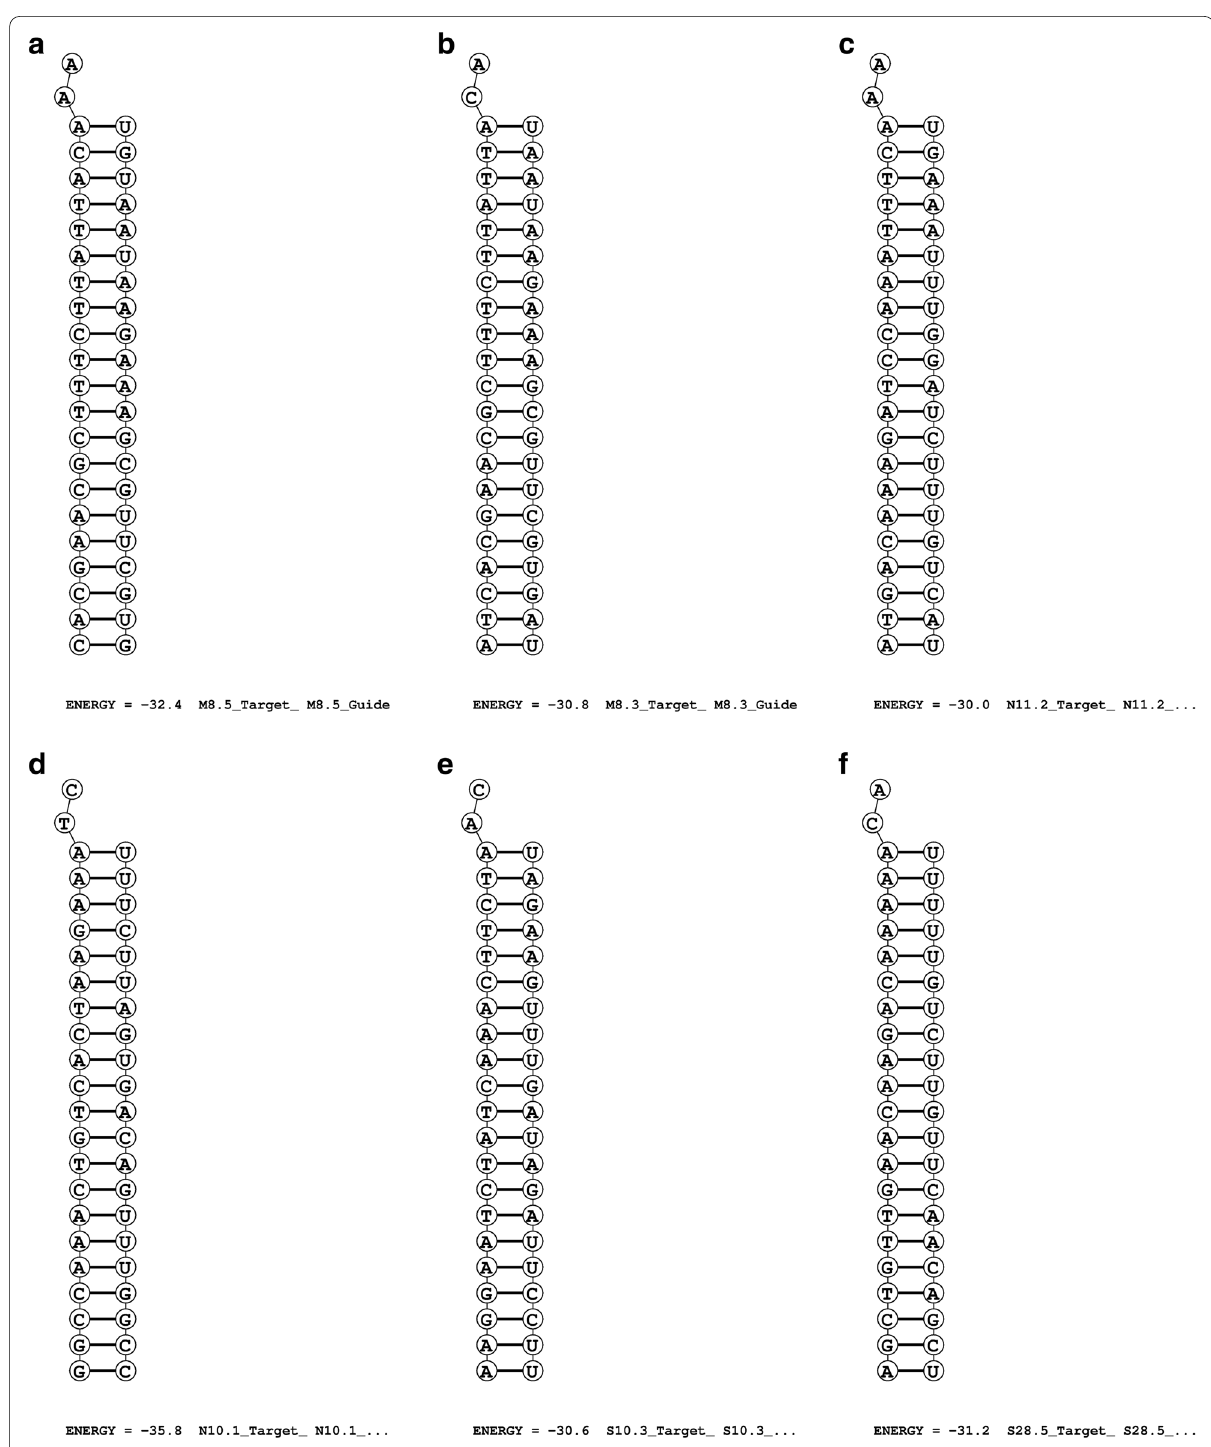
Fig. 2 a – f Lowest free energy structures of guide strands of siRNAs with their corresponding target regions and their energy